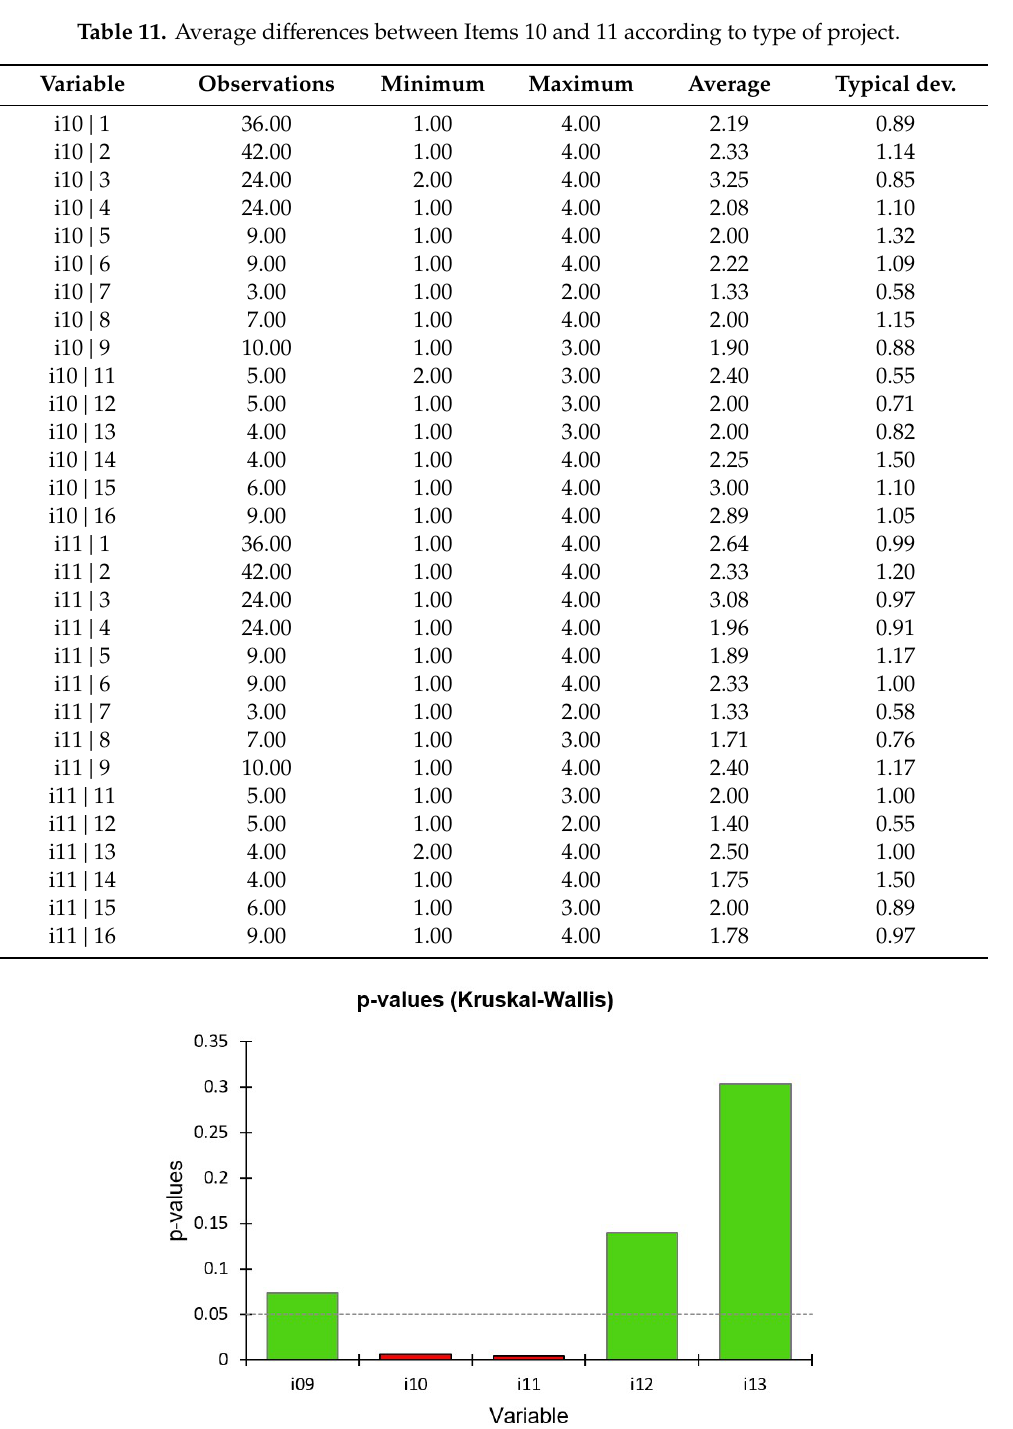
Figure 9. P -values of the Kruskal–Wallis test for items concerning the educational design of the program according to typology of project.